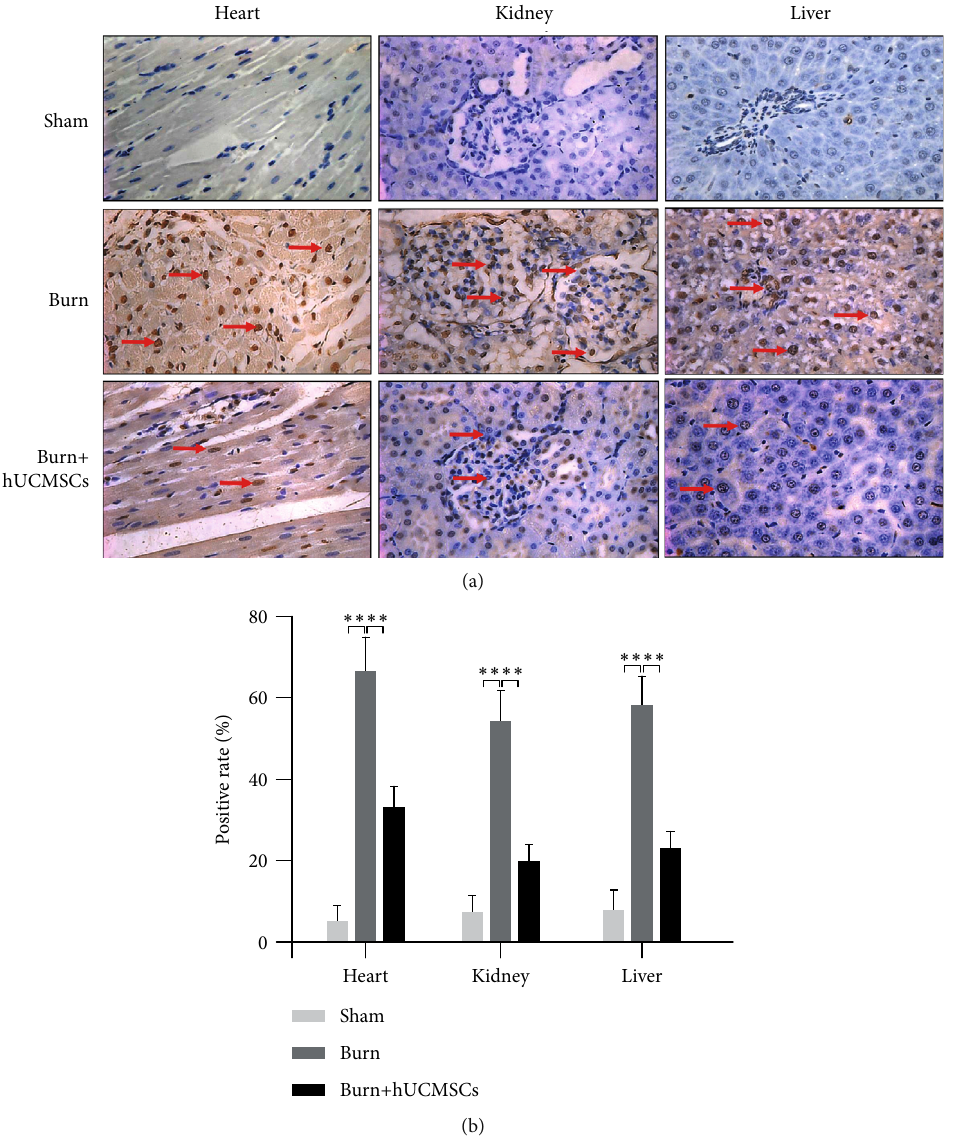
Figure 4: The hUCMSC administrations could signi fi cantly improve severe burn-induced cell apoptosis rates of the heart, kidney, and liver. (a) Cell apoptosis rates of vital organs in the burn group were signi fi cantly higher than those in the sham group, and they were signi fi cantly decreased in the burn+hUCMSC group than those in the burn group. (b) The result of the quantitative analysis is presented in the corresponding